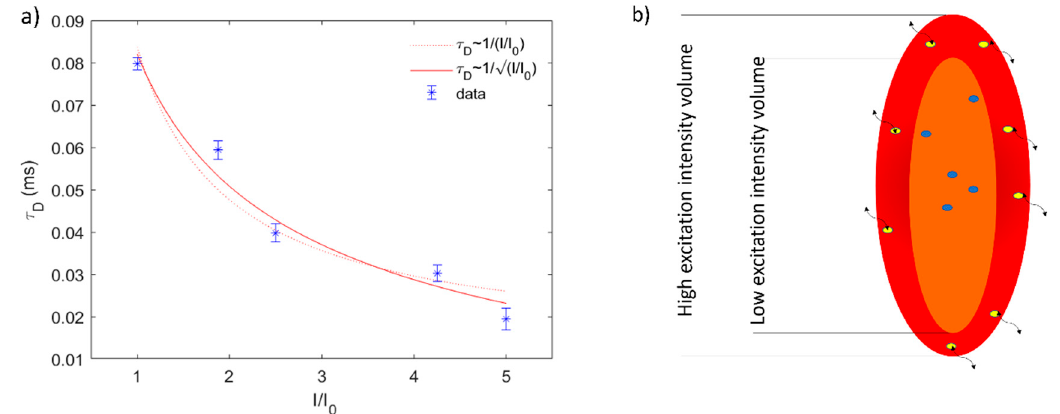
Figure 9. ( a ) Plot of the diffusion time acquired using simple data fit ( τ ~1/(I/I 0 ) 0.5 on autocorrelated data 10,000 ns) from experimental measurements of a Rhodamine B solution (10 nM), the 63× (NA 1.2) objective lens as a function of different laser powers. Data points in blue. Red lines represent fitting to two different models ( τ ~1/(I/I 0 ) 0.5 and τ ~(I/I 0 )) demonstrating a 1/r dependency where r is related to the size of focal volume, which will increase as laser power increases as shown in ( b ).